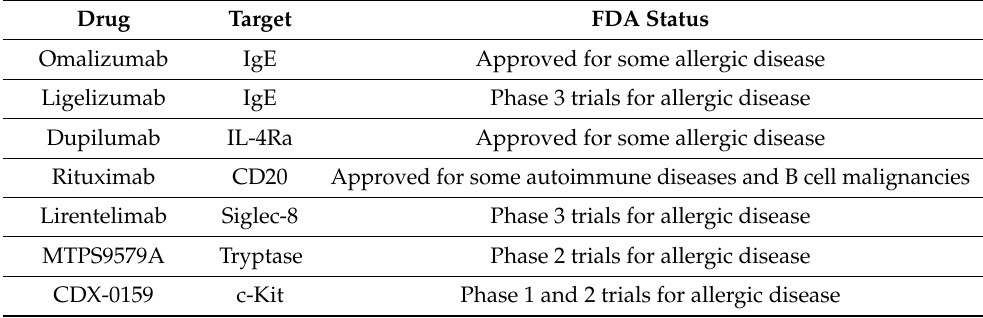
Table 1. Monoclonal antibodies with known or likely uses in allergic disease. Drug Target FDA